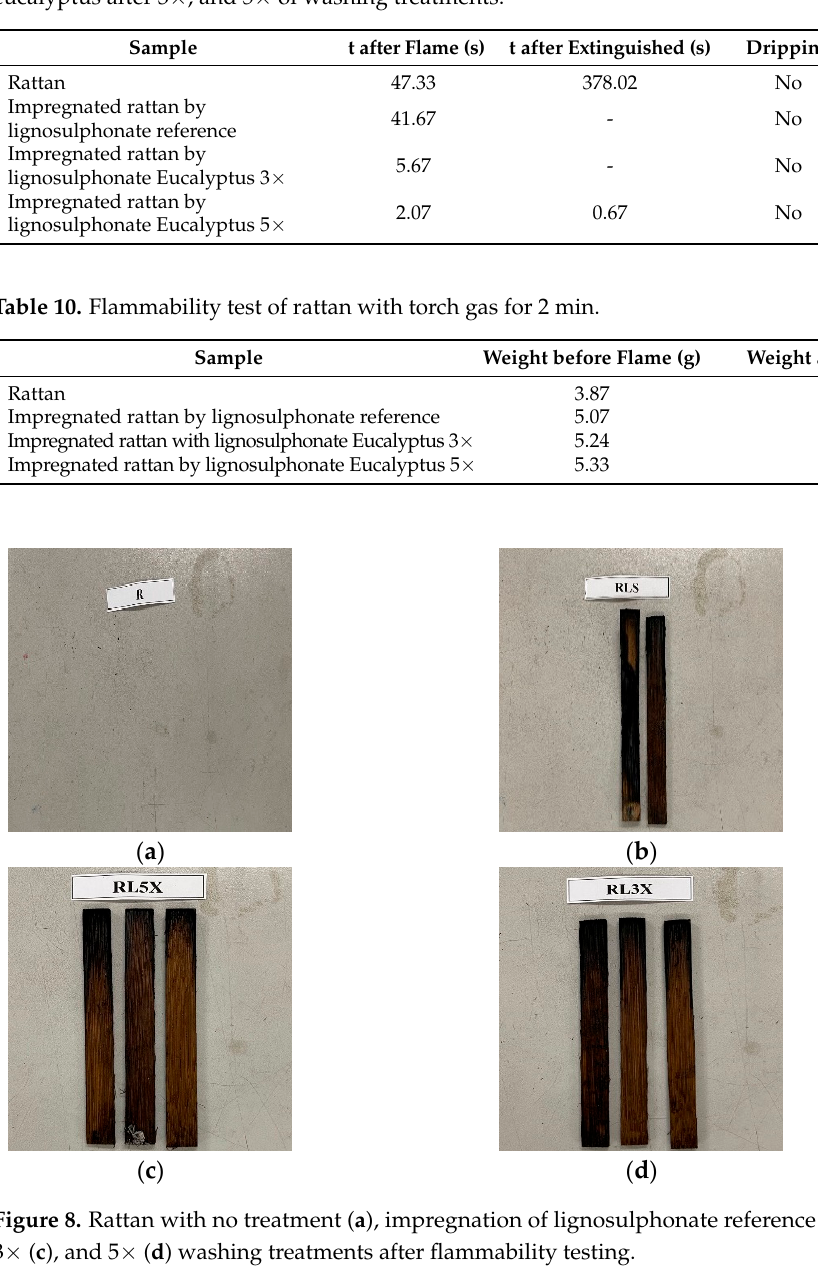
Table 9. UL-94 classification of rattan with no treatment, impregnation of lignosulphonate reference, eucalyptus after 3 × , and 5 × of washing treatments.